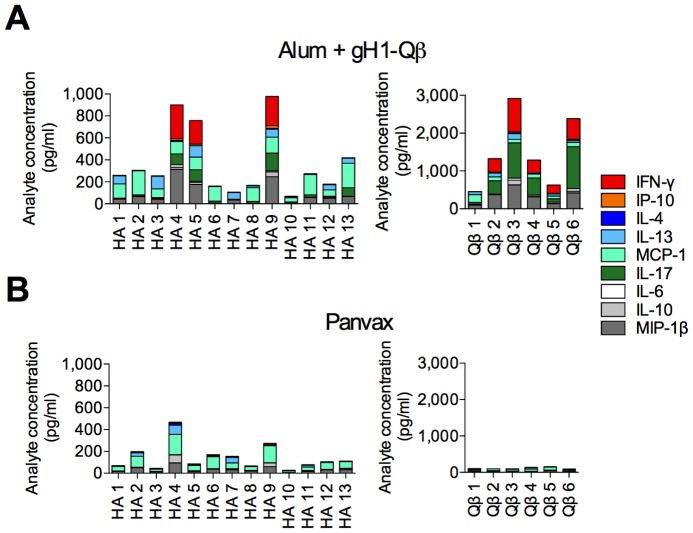
Alum-adjuvanted gH1-Qβ induces broad gH1 and Qβ specific T cell responses characterized by the production of IFNγ.HA and Qβ specific T cell responses were measured in pooled splenocytes from three BALB/c mice by secreted cytokine concentration after stimulation with peptide pools spanning the HA and Qβ regions of the gH1-Qβ vaccine. Mice were immunized with 10 µg alum-adjuvanted gH1-Qβ and 1.5 µg of Panvax. Each bar represents the total cytokine response to each peptide pool and each box the response to each cytokine. Names designated to each peptide pool are indicated on the x axes. Each data point is the response from splenocytes pooled from three mice.